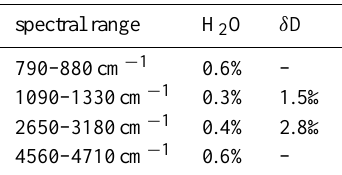
Table 3. Assumed experimental and temperature random uncer- tainty.